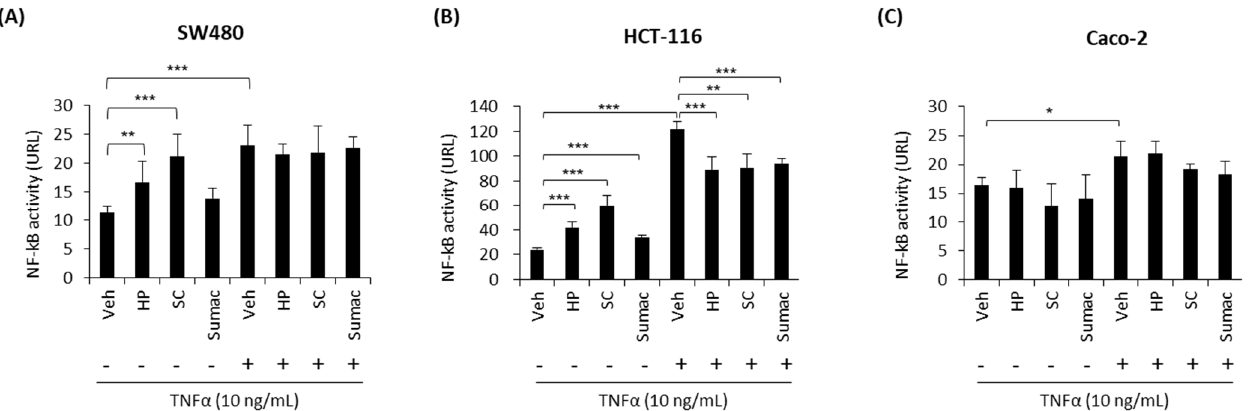
Figure 2. High phenolic sorghum bran extracts modulate NF- κ B activity in human colon cancer cells. SW480 ( A ), HCT- 116 ( B ) and Caco-2 ( C ) cells were transfected with NF-kB and pRL null luciferase plasmid for 24 h and pretreated with 2.5 mg/mL of sorghum bran extracts for 1 h and additionally incubated in the absence or presence of TNF- α (10 ng/mL) for 6 h. Luciferase was assayed using Dual Luciferase Assay System (Promega). Values are the mean ± SD (SW480, n = 6; HCT- 116, n = 4; Caco-2, n = 3). Significant differences between two groups are indicated as * p < 0.05, ** p < 0.01, *** p < 0.001.